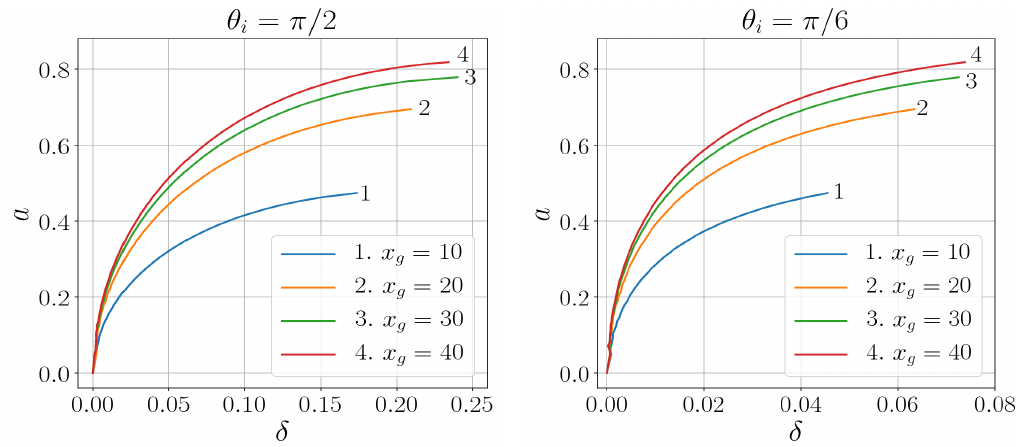
Figure 4. Left : Relation between the spin a and the distortion parameter for θ i = π /2. Right : Relation between the spin a and the distortion parameter for θ i = π /6.